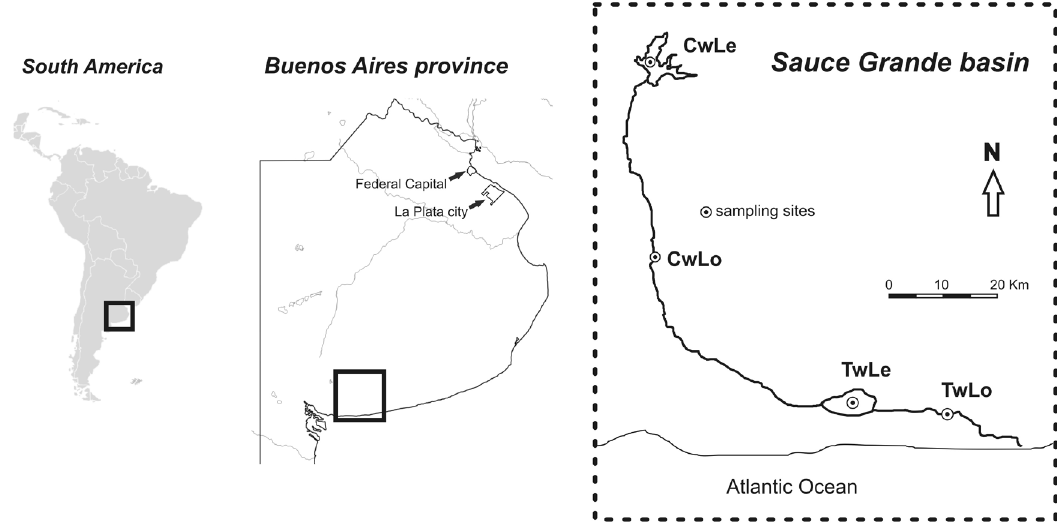
Figure 1. Location of sampling sites in the Sauce Grande River. CwLe = clear water lentic conditions at Paso de las Piedras Reservoir; CwLo = clear water lotic conditions at reach of Sauce Grande River downstream of the reservoir; TwLe = turbid water lentic conditions at Sauce Grande Lagoon; TwLo = turbid water lotic conditions at reach of Sauce Grande River downstream of the